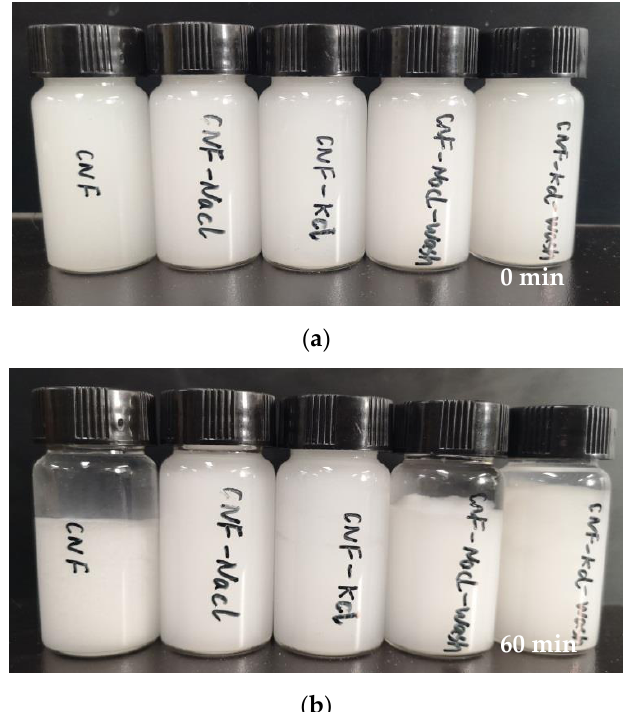
Figure 4. Images of sedimentation test after ( a ) 0 min and ( b ) 60 min.